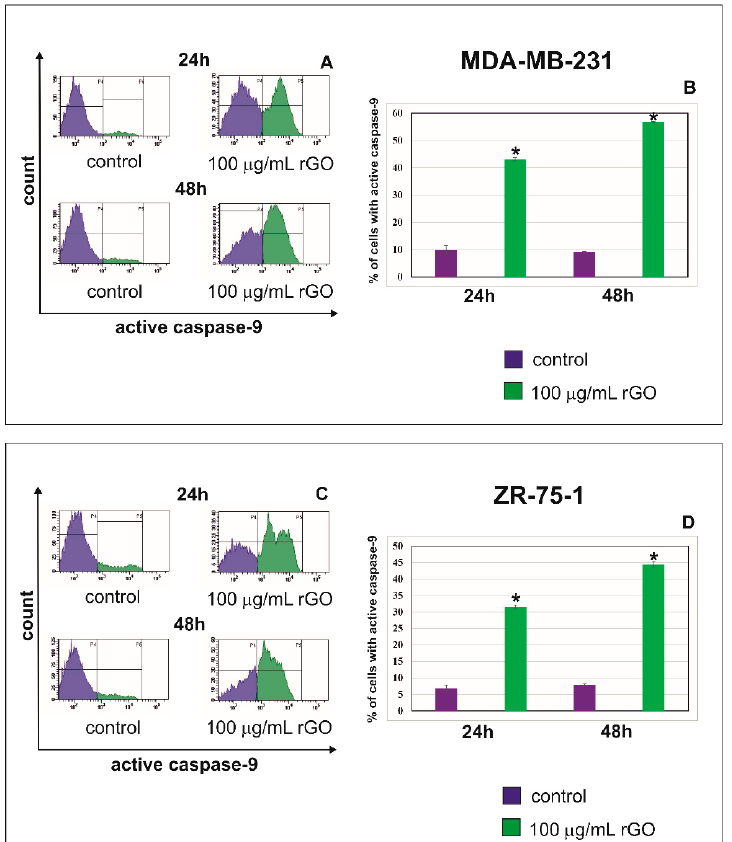
Figure 5. The flow cytometry analysis of active caspase-9 in MDA-MB-231 ( A , B ) and ZR-75-1 ( C , D ) cells. The cells were treated with 100 µ g/mL of rGO for 24 and 48 h. Panels ( A , C ) show the representative histograms of MDA-MB-231 ( A ) and ZR-75-1 ( C ) cells stained with FAM-FLICA Caspase-9. Panels ( B , D ) show the percentage of MDA-MB-231 ( B ) and ZR-75-1 ( D ) cells with active caspase-9. Gate P4—populations of cells without of active caspase-9; gate P5—population of cells with active caspase-9. The right panel shows the percentage of MDA-MB-231 ( B ) and ZR-75-1 ( D ) cells with active caspase-9. Significant alterations are expressed relative to controls and marked with asterisks. * p <